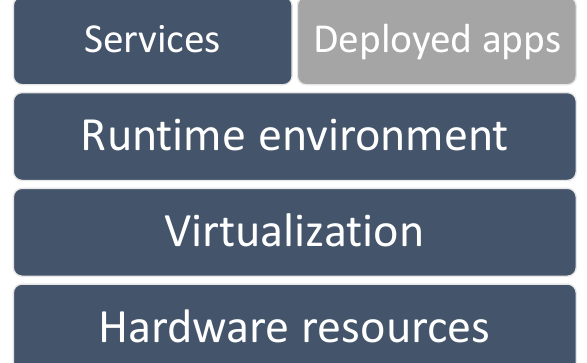
Fig. 2. Resources commonly abstracted by PaaS environments.